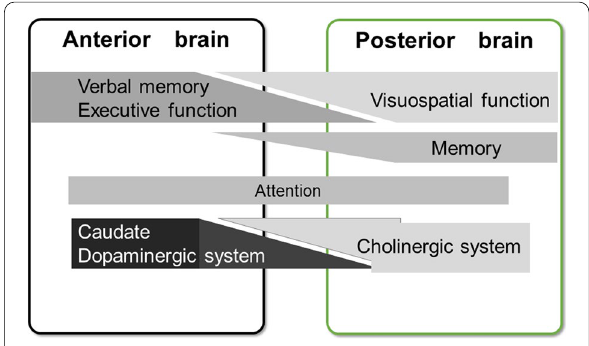
Fig. 3 Schematic diagram of dual syndrome hypothesis (modified from Kehagia et al.